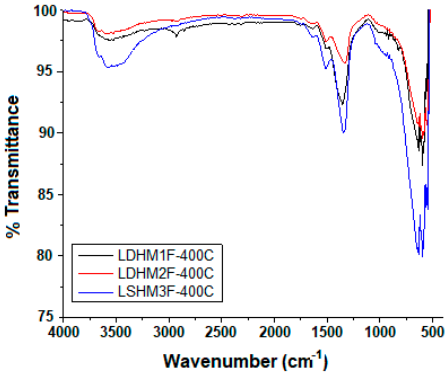
Figure 3. Fourier transformed infrared spectra of activated Mg / Fe layered double hydroxides.